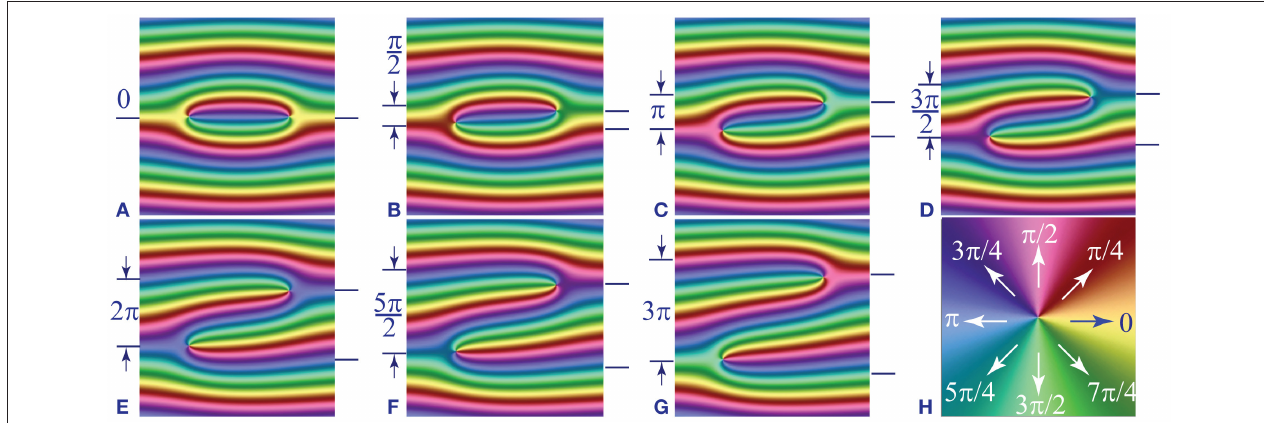
FIGURE 3 | Collision of a pair of dowsons d + and d − imbedded in a wound up dowser texture. The distance of their trajectories in terms of the phase difference 1ϕ varies between 0 to 3 π from (A–G) . The color code for the phase is given in (H)